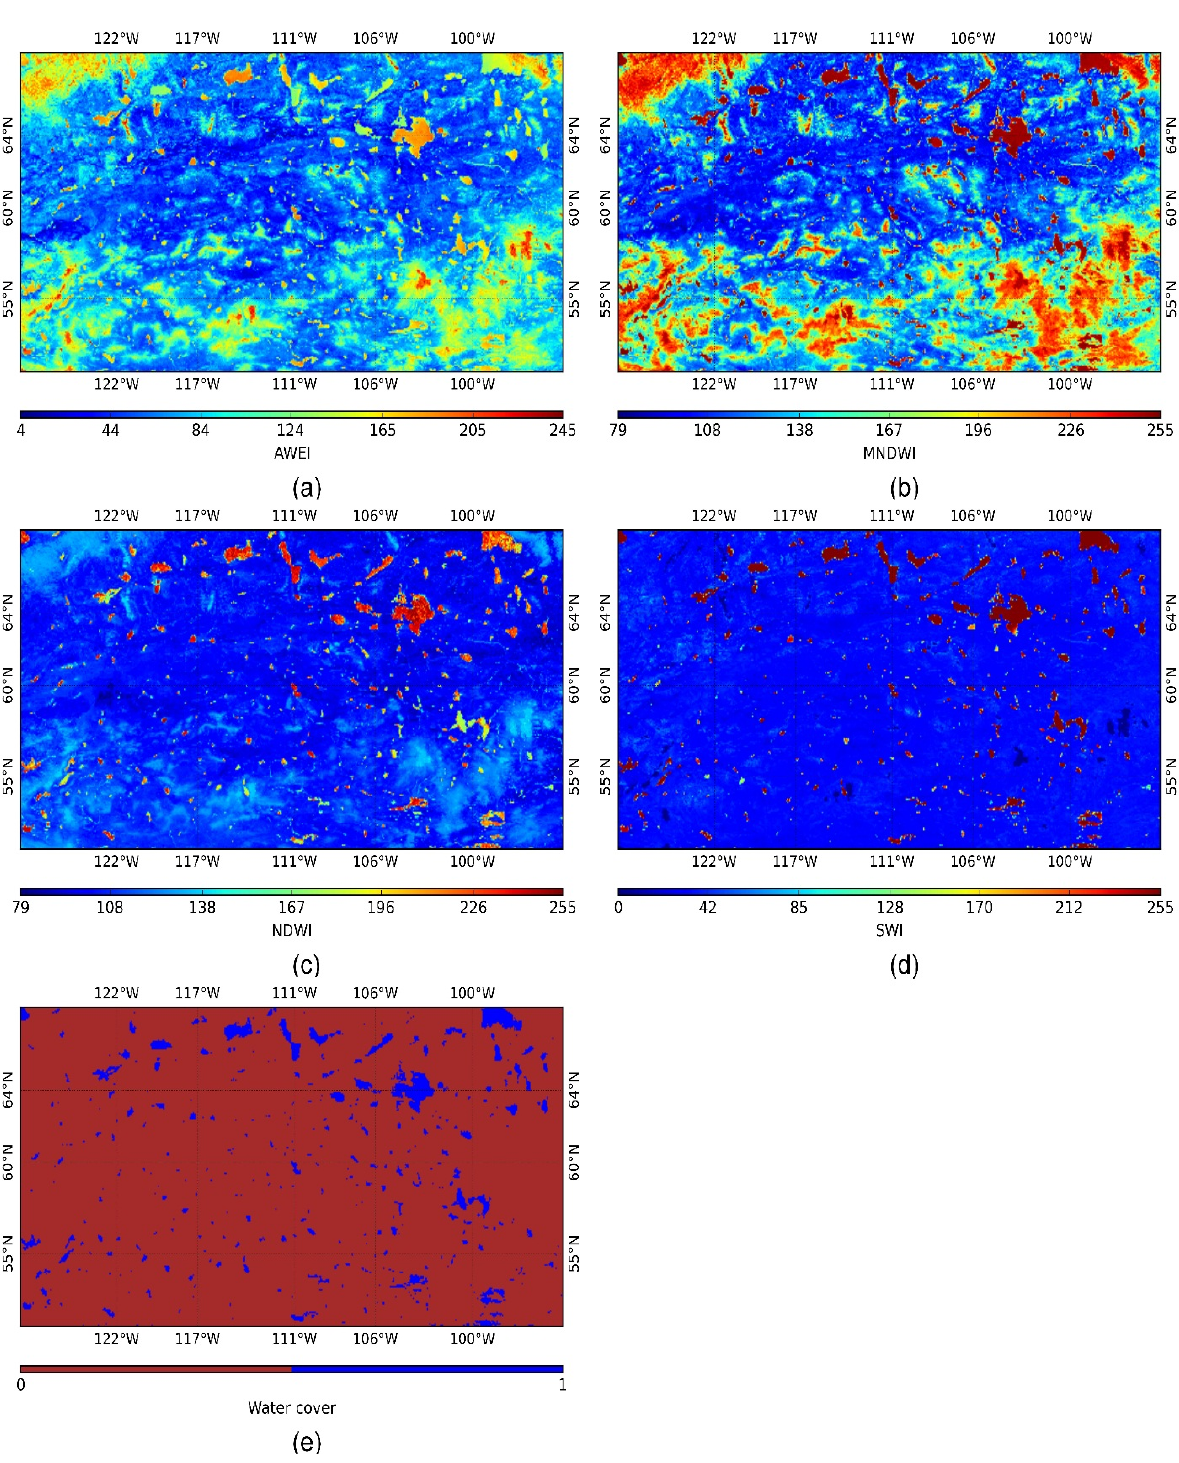
Figure 6. Plotting of four water indices and water cover map in a dry region: ( a ) Automated Water Extraction Index (AWEI), ( b ) Modified Normalized Difference Water Index (MNDWI), ( c ) Normalized Difference Water Index (NDWI), ( d ) Superfine Water Index (SWI), ( e ) Reference water cover